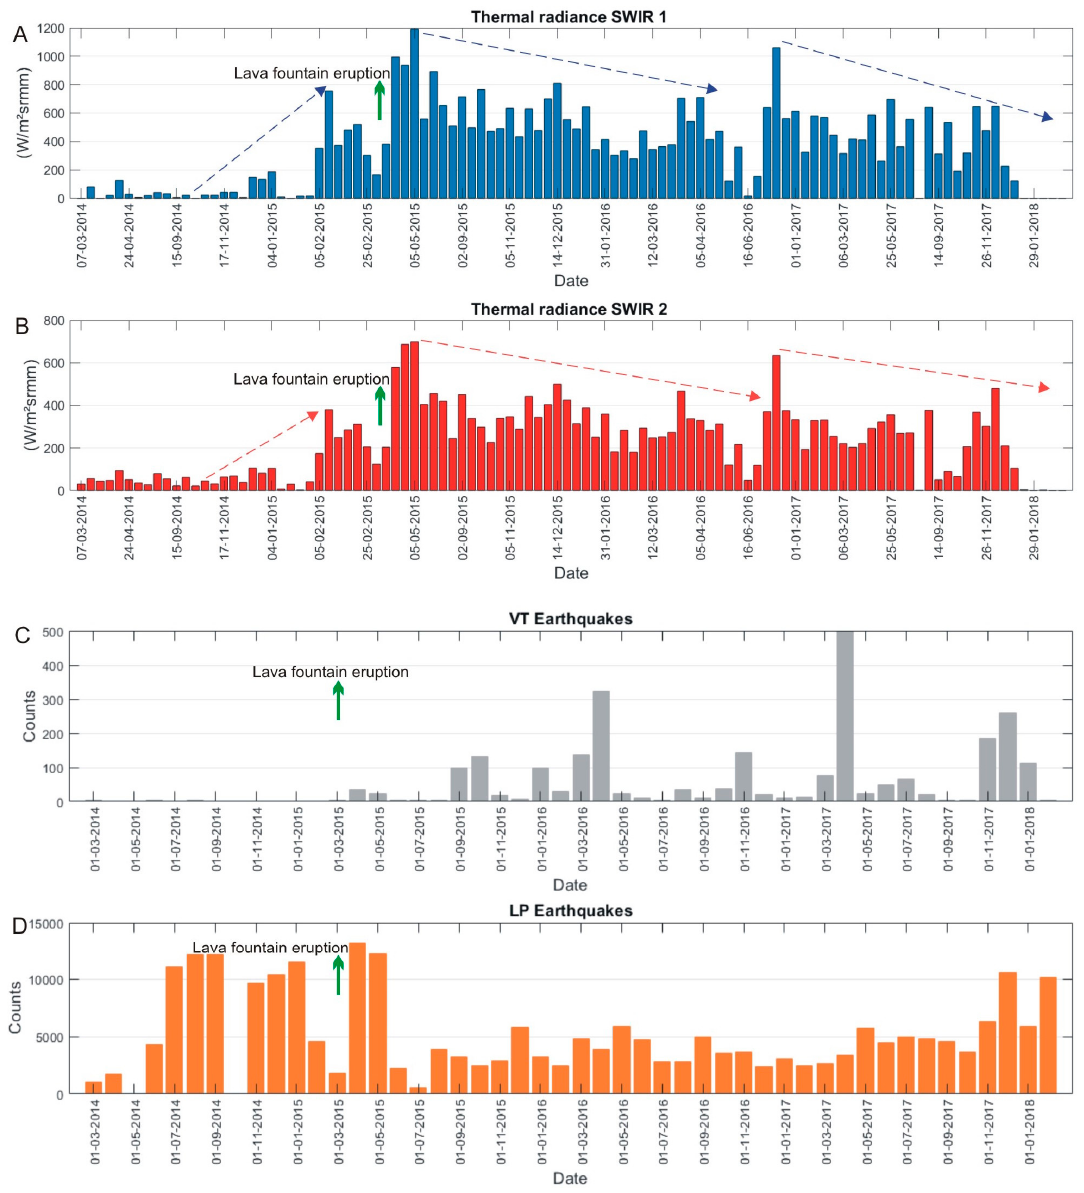
Figure 7. Villarrica Volcano ( A ) Thermal radiance of SWIR1 band vs. date for the period March 2014–February 2018. ( B ) Thermal radiance of SWIR2 band vs. date for the period March 2014–February 2018. ( C ) VT seismicity vs. date for the period March 2014–February 2018. ( D ) LP seismicity vs. date for the period March 2014–February 2018. The upward arrows show the occurrence of the March 3, 2015, Hawaiian eruption.